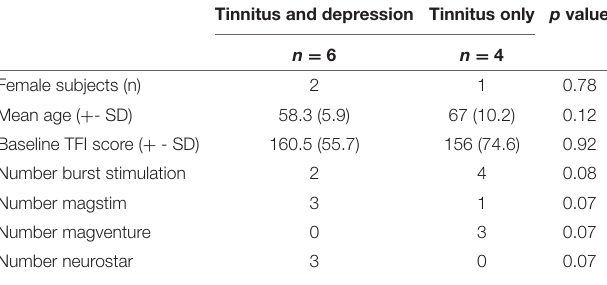
TABLE 1 | Demographics, baseline characterstics, and basic treatment parameters of subjects in each